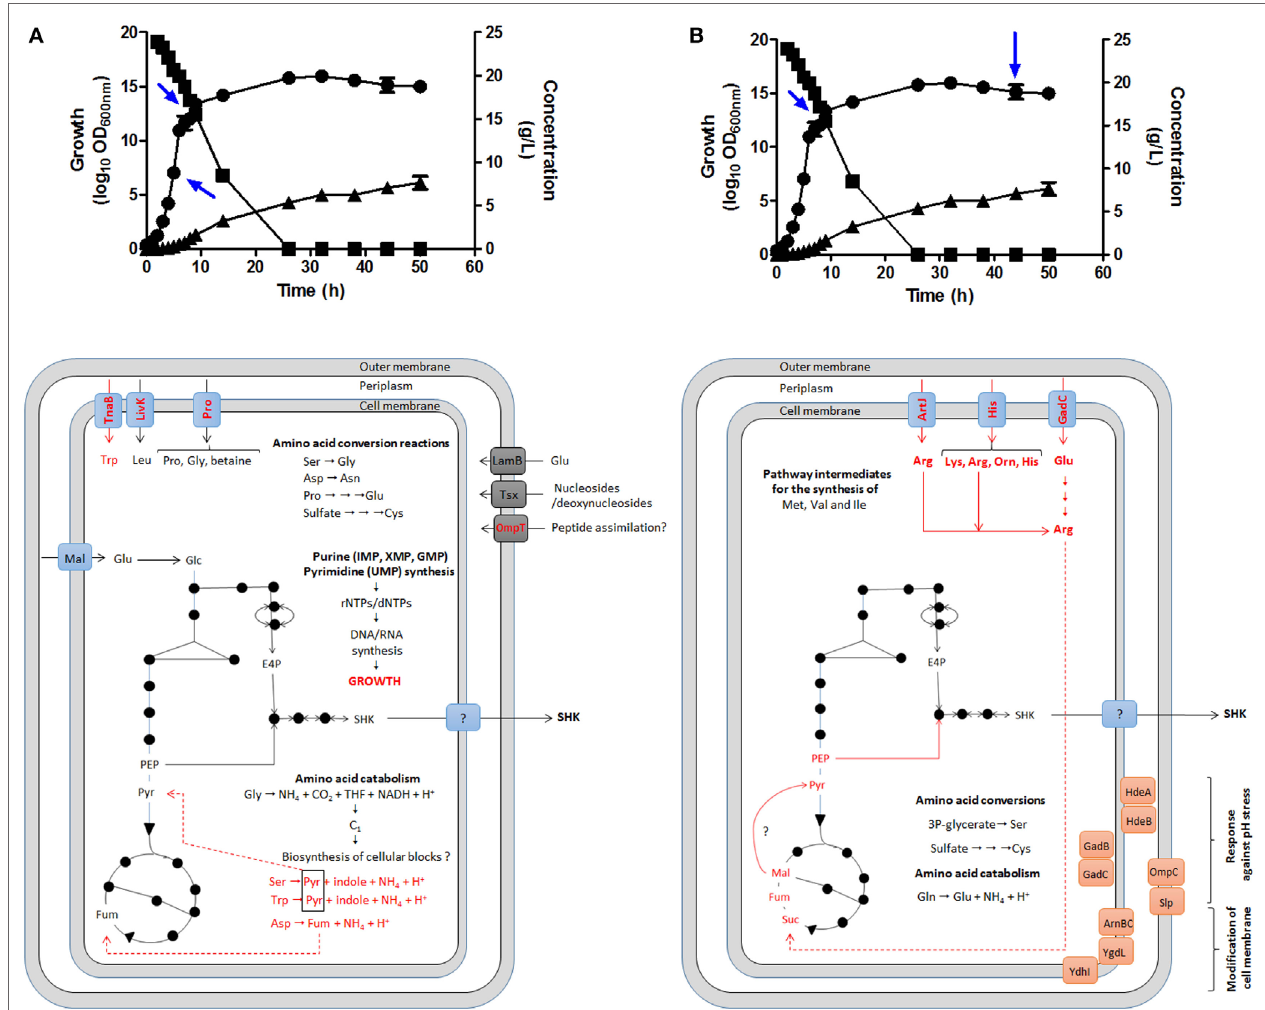
FiGURe 5 | identification of possible key genes involved in carbon supply for SA synthesis as determined by global transcriptomic analysis in E. coli PB12.SA22 in batch culture using complex fermentation broth . Global transcriptomic analysis (GTA) showed no changes in expression profile in comparisons between EXP/STA1 (A) and STA1/STA2 (B) stages of those genes coding for enzymes of CCM and SA pathways but differential overexpression of diverse genes involved the transport, catabolism and interconversion of amino acids was observed (in red color) [ (A,B) , lower panels]. During STA1/STA2 comparison, genes coding for l -arginine, l -lysine, l -glutamic acid, and l -ornithine transporters were upregulated. These amino acids are probably converted to succinate fueling carbon to TCA. Additionally diverse genes coding for stress response proteins to pH and osmotic pressure were overexpressed. Blue arrows in upper panels showed samples from fermentor culture analyzed for GTA. Growth (•), glucose consumption ( ▪ ), and SA production ( ▴ ). Adapted from Escalante et al. (2010), Keseler et al. (2013), and Cortés-Tolalpa et al.